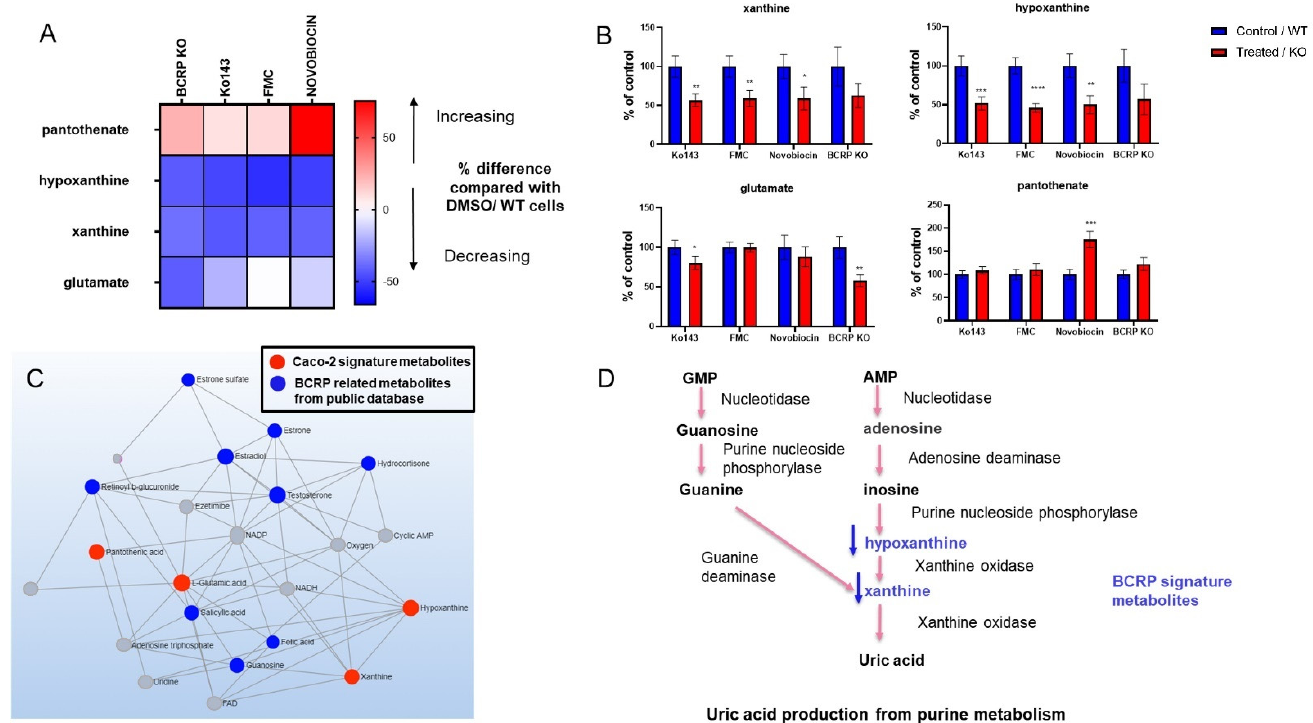
Figure 3. Heat map ( A ) and bar graphs ( B ) representing changes in metabolites in cells treated with BCRP inhibitors and BCRP KO cells. The data represent changes in metabolites in response to BCRP KO and BCRP inhibition by Ko143 (10 µM), FMC (5 µM) and novobiocin (30 µM). The data repre- senting changes in Ko143 inhibition were acquired from 3 individual experiments, each experiment was performed with minimum 6 replicates, and the data are presented as the mean of 3 repeats. The data from other inhibitors and BCRP KO represent the mean of 1 independent experiment, which was performed with at least 6 replicates. ( A ) The data are presented as the percentage change com- pared with control (DMSO/WT). ( B ) The data were normalized by dividing the mean (peak area) of treated/KO group with the control group and is presented as a percentage (mean ± SEM) of the control group. The significance of these results was determined using Mann–Whitney test, and re- sults with * p < 0.05, ** p < 0.01, *** p < 0.001, **** p < 0.0001 were considered significant. ( C ) Metabo- lite–metabolite network analysis based on BCRP signature metabolites (red dot) identified in our lab and BCRP related metabolites from public databases (blue dots) (grey dots: other metabolites in the network generated by MetaboAnalyst). ( D ) BCRP signature metabolites are involved in purine metabolism and lead to production of uric acid, which is a well-known BCRP substrate.